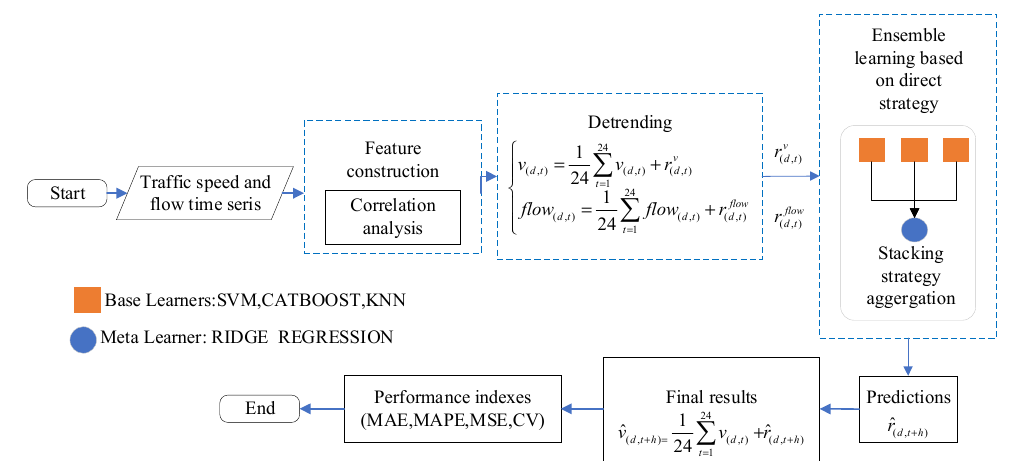
Figure 2. The framework of the proposed predictor (DDSELM) in this study.